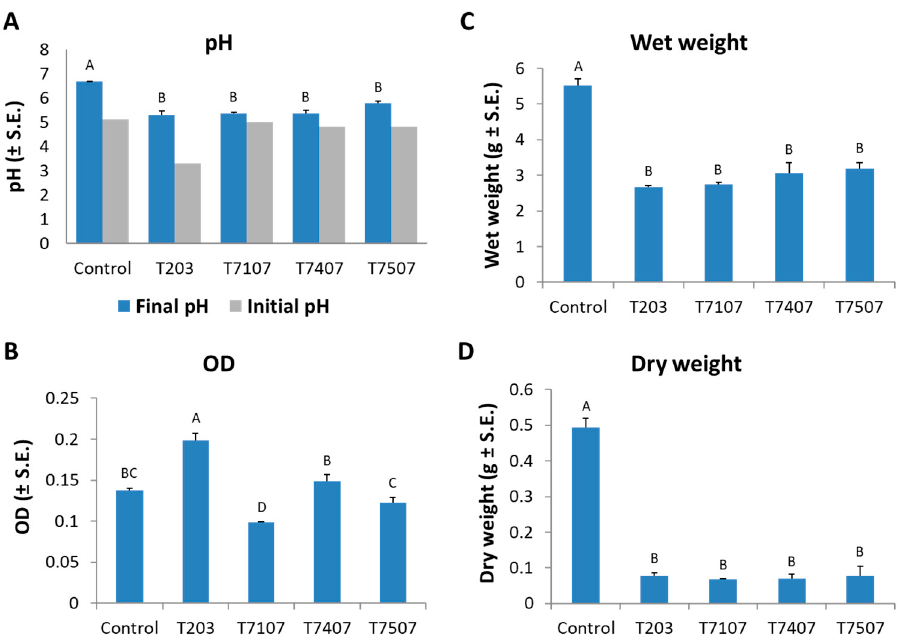
Figure 2. Effect of the growth fluid metabolites of Trichoderma isolates on the development of M. maydis submerged cultures. The Trichoderma species tested are listed in Table 1. All the colonies ( Trichoderma spp. and M. maydis ) were grown for 6 days. The control is potato dextrose broth (PDB) medium M. maydis cultures maintained at the same conditions. ( A ) Substrate acidity after Trichoderma spp. growth (gray bars) and after pH adjustment to 5.1 and the growth of M. maydis in those media (blue bars). At the experiment end (after M. maydis growth), the following parameters were measured: ( B ) The growth media turbidity (high optical density (OD) is the consequence of degradation of M. maydis mycelia into many fragments). ( C ) M. maydis wet weight. ( D ) M. maydis dry weight. The error lines represent a standard error of 5 repetitions (except for the initial pH bars in ( A ), the stock growth solution, i.e., one repeat). Statistical significance ( p < 0.05) of variance was tested using a one-way ANOVA test and represented by different letters (A–D) above the chart bars.